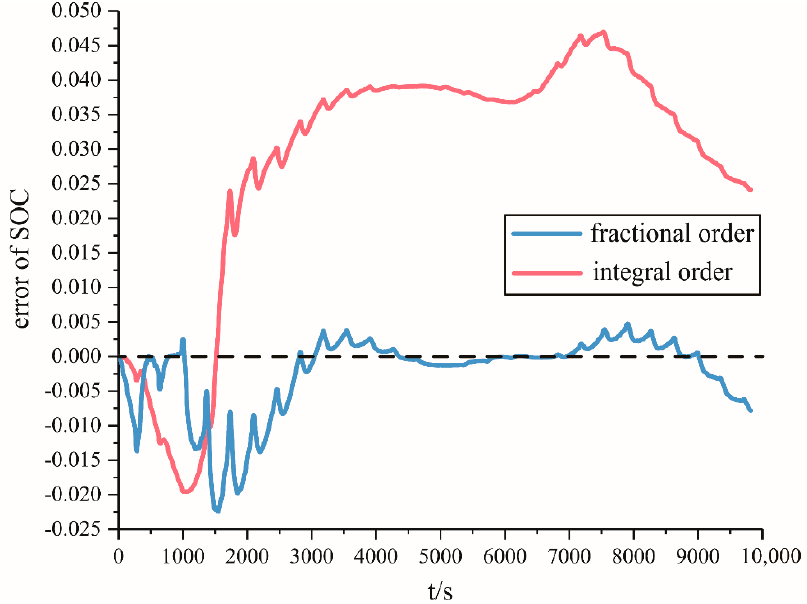
Figure 18. Comparison of SOC errors between FEKF and EKF under 26 continuous DST conditions at 28 °C. Energies 2020 , 13 , x FOR PEER REVIEW